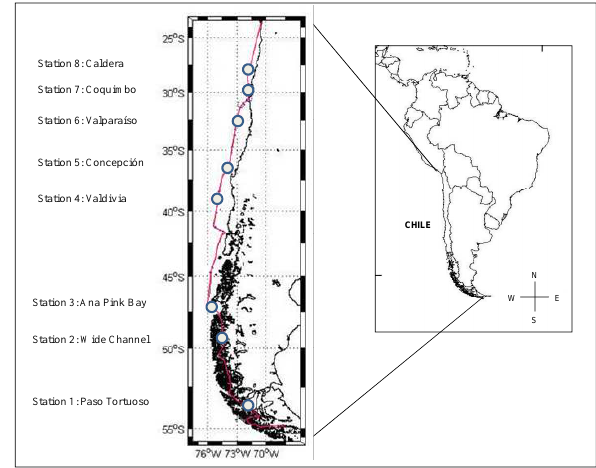
Fig. 1. Map of the study area showing the cruise track and the sta- Figure 1. Map of the study area showing the cruise track and the stations where submarine UV tions where submarine UV penetration and community metabolism penetration and community metabolism were measured. were